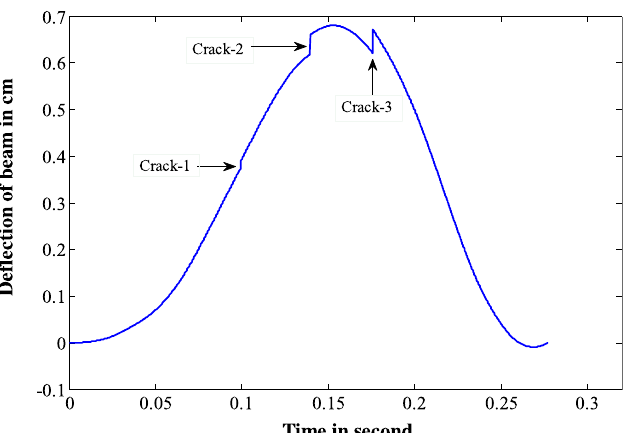
Fig. 4. Graph for crack detection at M =1.13 kg, v =5.12 m/s, h 1,2,3 = 0.358, 0.503, 0.634, a 1,2,3 = 0.358,